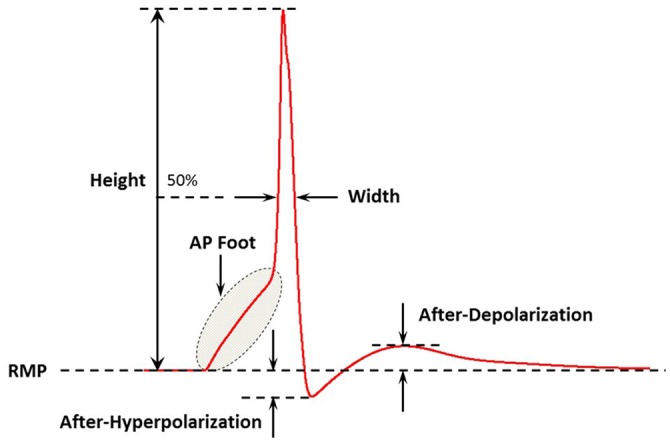
A schematic figure showing the key features of the action potential profile which were used in the study. Adapted from Appukuttan et al. (2015a).